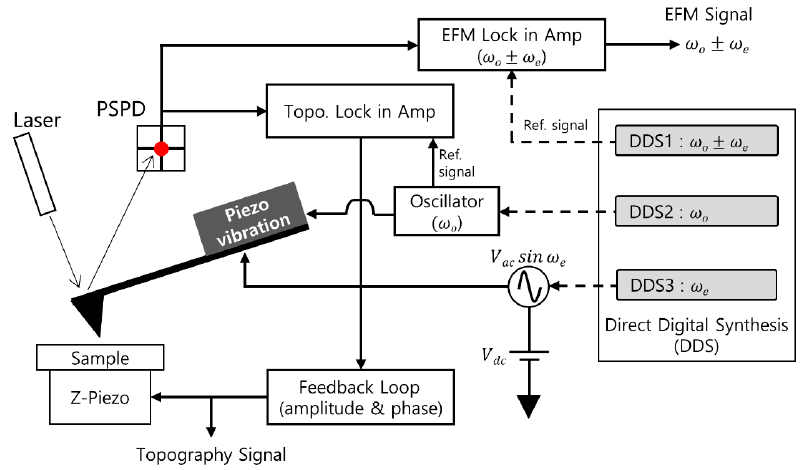
Figure 1. Schematic set-up of the electrostatic force microscopy (EFM) using a direct digital synthesizer (DDS). The vibration of the oscillator with a natural frequency of ω o , alternating current (AC) voltage with a frequency of ω e , and EFM signals with a side-band frequency of ω o ± ω e were operated by the DDS.